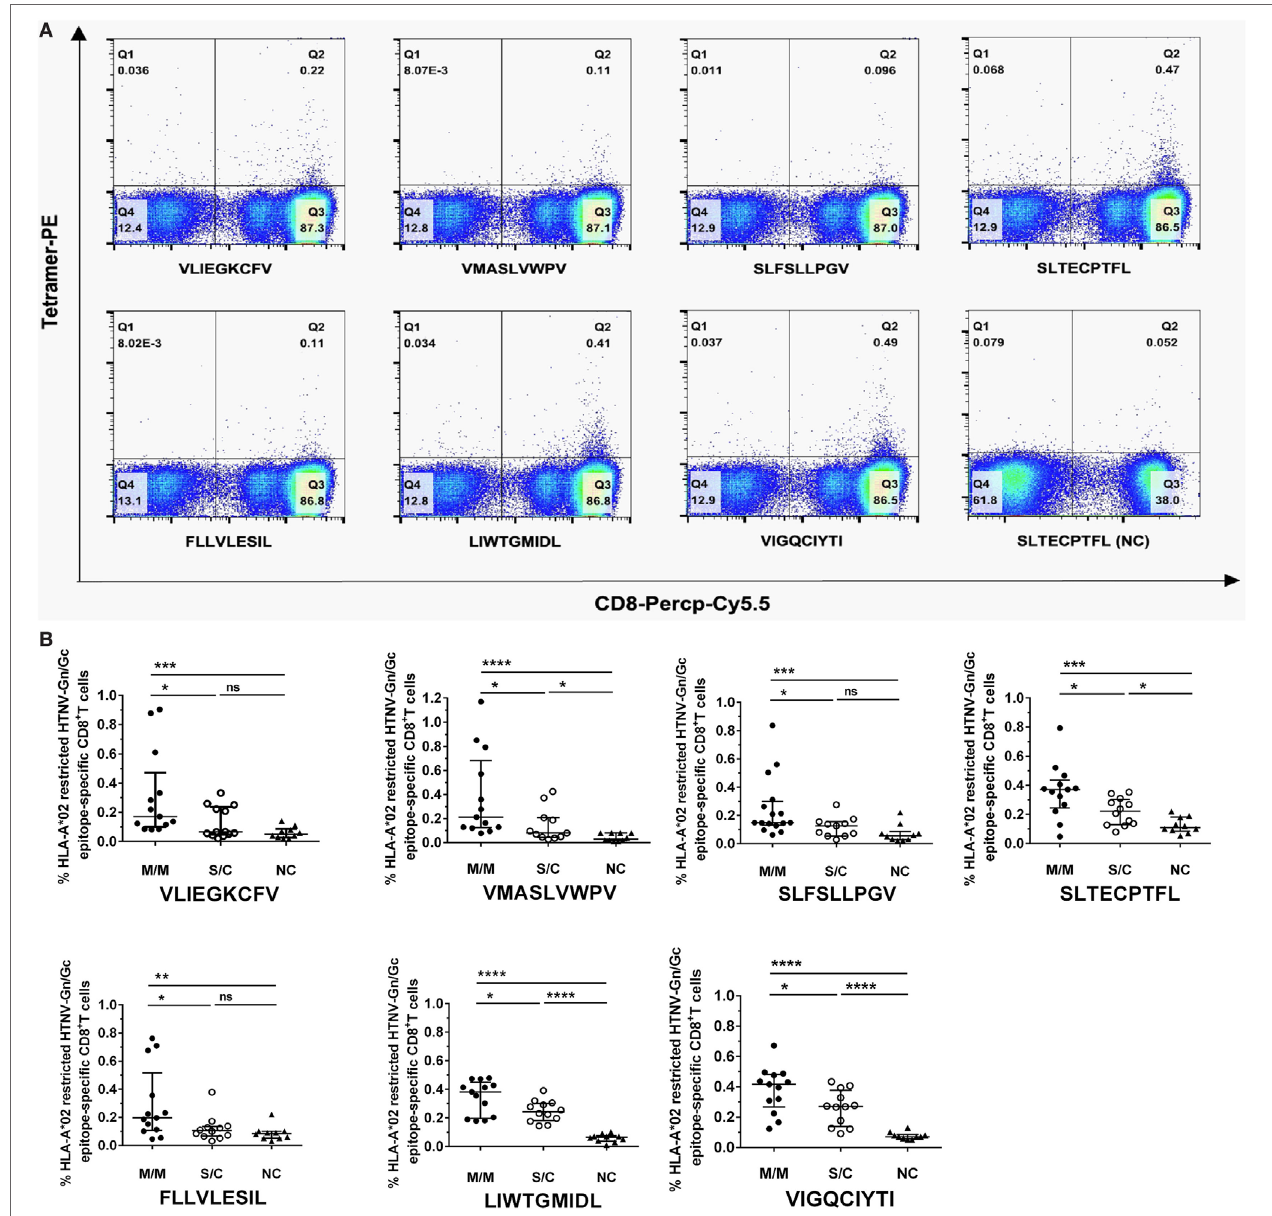
FigUre 2 | Frequencies of HLA-A*02-restricted Hantaan virus (HTNV) glycoprotein (GP) epitope-specific CTLs in peripheral blood mononuclear cells (PBMCs) of hemorrhagic fever with renal syndrome (HFRS) patients and their relationship with disease severity. The PBMCs from HLA-A*02 + HFRS patients in the acute phase of HFRS were stained with HLA-A*0201 tetramer preloaded with seven high HLA-A*0201-binding affinity peptides, respectively (including VLIEGKCFV, VMASLVWPV, SLFSLLPGV, SLTECPTFL, FLLVLESIL, LIWTGMIDL, and VIGQCIYTI). HLA-A*0201/peptide tetramer + cells gated from CD3 + CD8 + T lymphocytes were considered epitope-specific CTLs. (a) The frequencies of seven HTNV GP epitope-specific CTLs of the same HFRS patient (a 52-year-old male with moderate disease severity) and an HLA-A*02 + healthy donor [normal control (NC)]. (b) Comparison of the seven HLA-A*02-restricted HTNV GP epitope-specific CTL frequencies among patients with mild/moderate disease severity (M/M), patients with severe/critical disease severity (S/C) in the acute phase and NC. The Mann–Whitney U test was used to determine the significance of differences between two groups, and black lines represent the medians with the corresponding interquartile ranges. p -Values below 0.05 ( p < 0.05) were considered statistically significant, * p < 0.05, ** p < 0.01, *** p < 0.001, **** p < 0.0001, ns indicates no significant